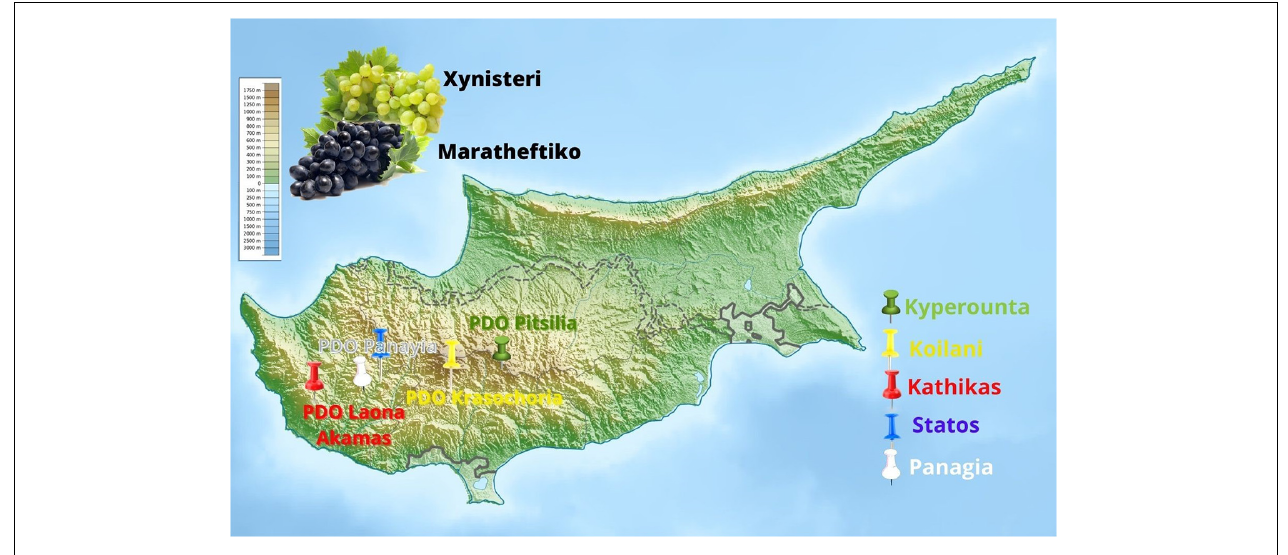
FIGURE 1 | Map of wine grape sampling